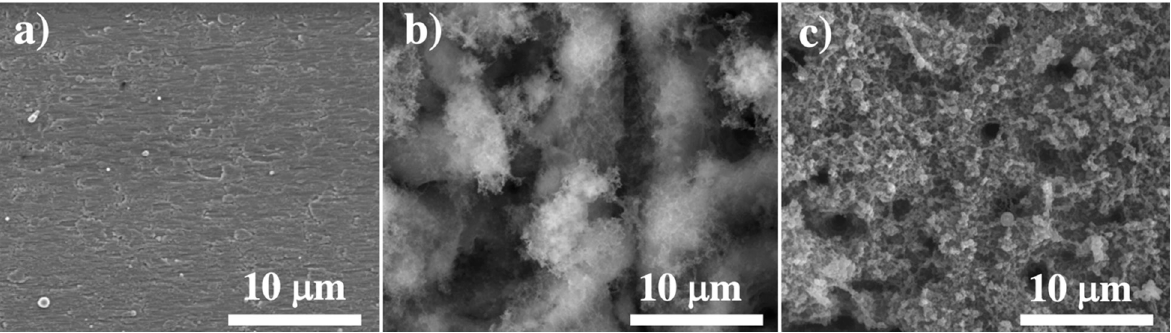
Figure 1. A. SEM images of ( a ) control sample (S1:CS), ( b ) S2 (600 kHz), and ( c ) S3 (1200 kHz).